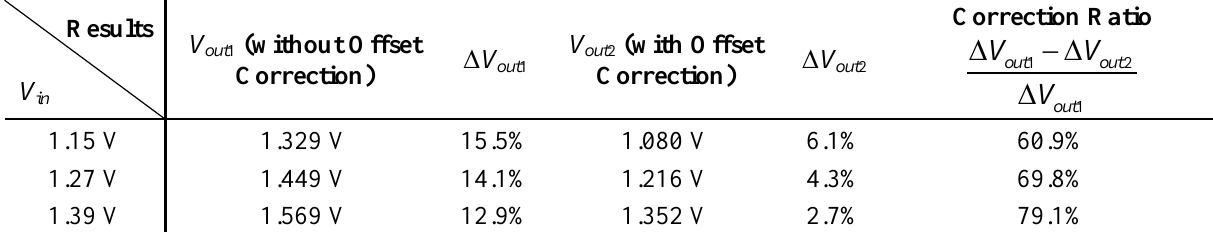
Table 2. Performance of the correction